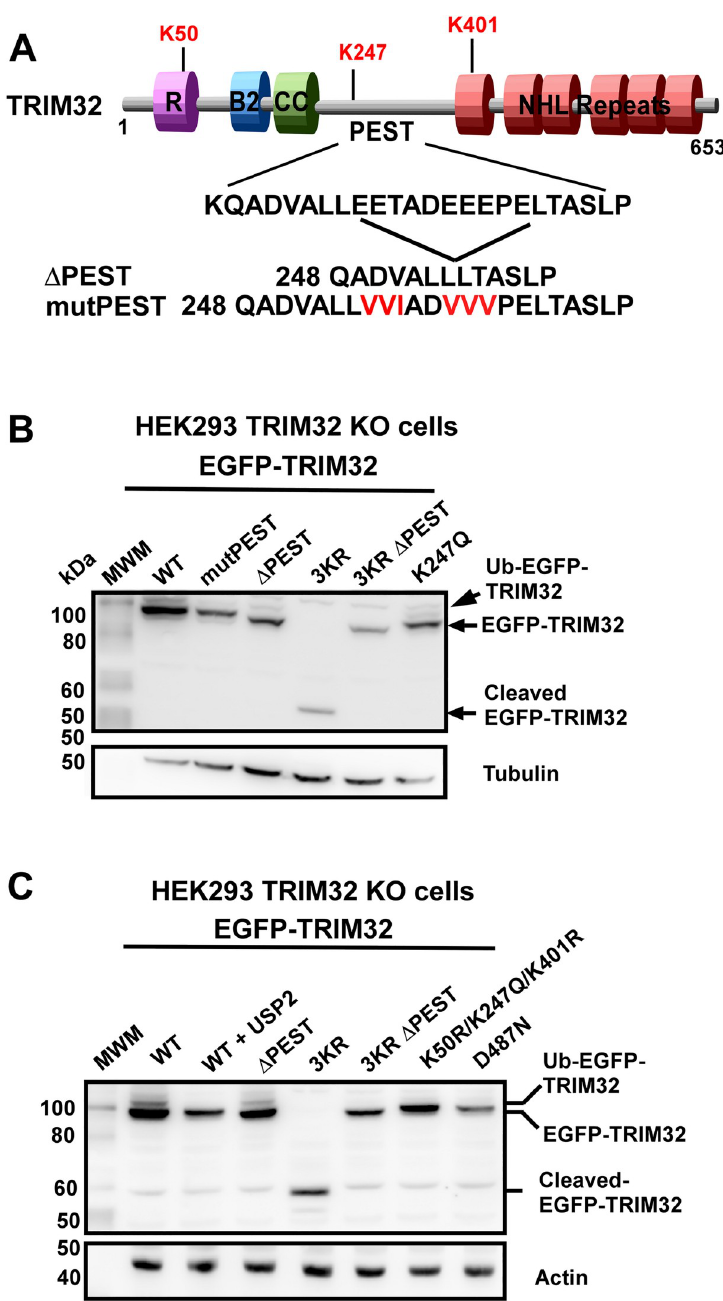
Fig 4. Acetylation of K247 protects TRIM32 from cleavage directed by the adjacent PEST sequence. (A) Schematic of TRIM32 domain organization with the three regulatory Lysine residues identified in this work indicated above, and the sequence of the mapped PEST sequence indicated below. MutPEST and Δ PEST display the modifications introduced to the predicted PEST sequence. (B) Western Blot analysis of cell extracts from HEK293 FlpIn TRIM32 KO cells transiently transfected with expression plasmids for EGFP-TRIM32 WT , EGFP-TRIM32 mutPEST , EGFP-TRIM32 Δ PEST , EGFP-TRIM32 K50R/K247R/K401R (3KR), TRIM32 K50R/K247R/K401R/ Δ PEST (3KR Δ PEST) or EGFP-TRIM32 K247Q . The bands representing EGFP-TRIM32 and cleaved EGFP-TRIM32 are indicated to the right. Tubulin represents the loading control. (C) Western Blot analysis of cell extracts from HEK293 FlpIn TRIM32 KO cells transiently transfected with expression plasmids for EGFP-TRIM32 WT , EGFP-TRIM32 WT and mCherry-USP2, EGFP-TRIM32 Δ PEST , EGFP-TRIM32 K50R/K247R/K401R (3KR), TRIM32 K50R/K247R/K401R/ Δ PEST (3KR Δ PEST) or EGFP-TRIM32 K50R/247Q/K401R or EGFP-TRIM32 D487N . The bands representing ubiquitylated EGFP-TRIM32, EGFP-TRIM32 and cleaved EGFP-TRIM32 are indicated to the right. Actin represents the loading control.